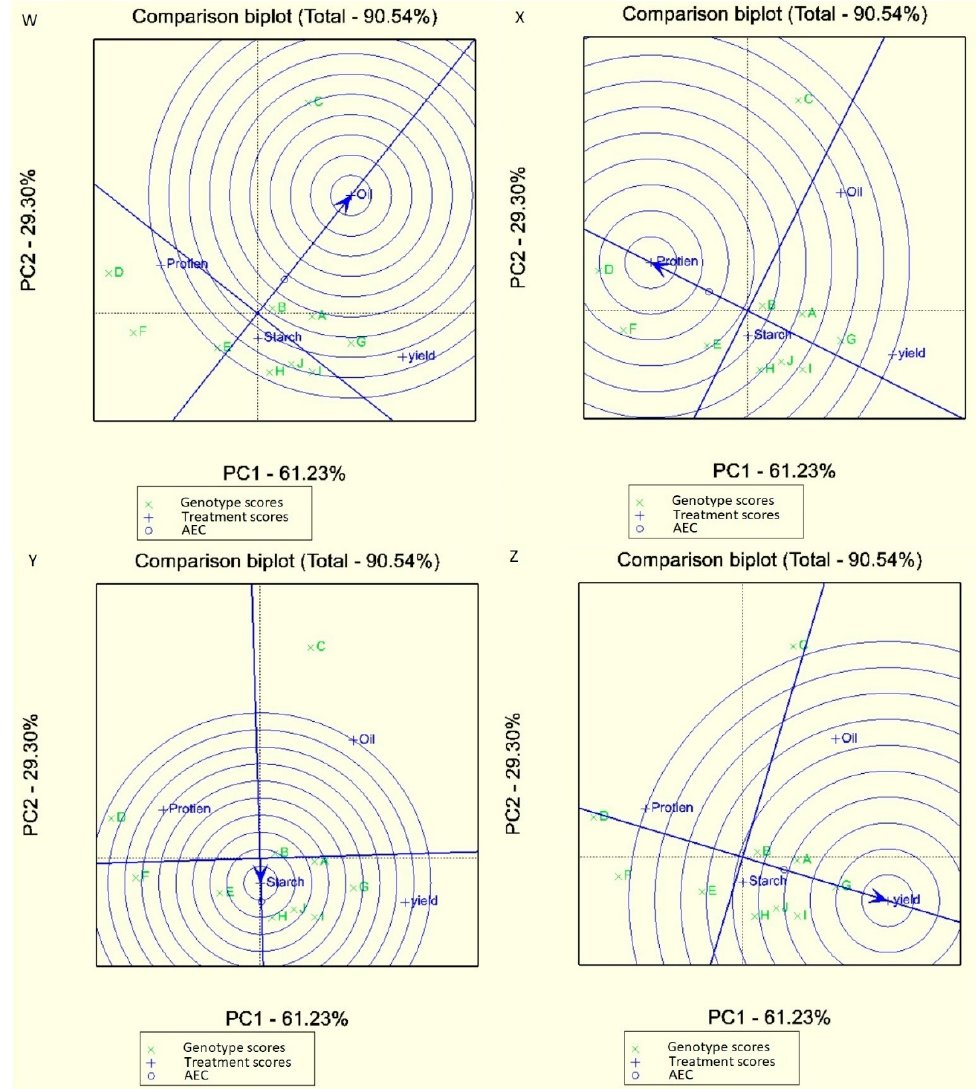
Figure 4. GGE biplot hybrids in NPK fertilizer (first treatment),( W ): oil content, ( X ): protein content, ( Y ): Starch content, ( Z ): Grain yield; A (FAO300), B (FAO330), C (FAO340), D (FAO350), E (FAO380), F (FAO360), G (FAO420), H (FAO490), I (FAO370), J (FAO430); Yield(grain yield), Starch (starch content), Protein (protein content), Oil (oil content).